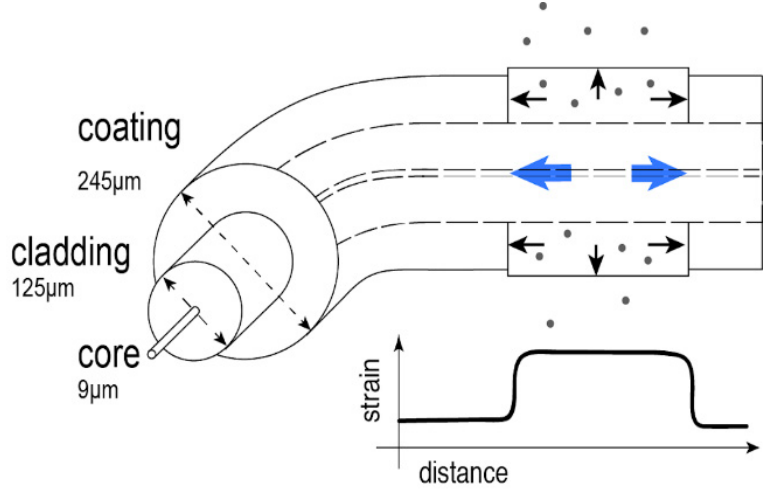
Figure 1. Distributed chemical sensing principle using conventional acrylate coated optical fibers. Gray dots represent an analyte in solution that is penetrating a section of the permeable coating. As the coating swells, it applies a local axial tensile strain on the fiber.